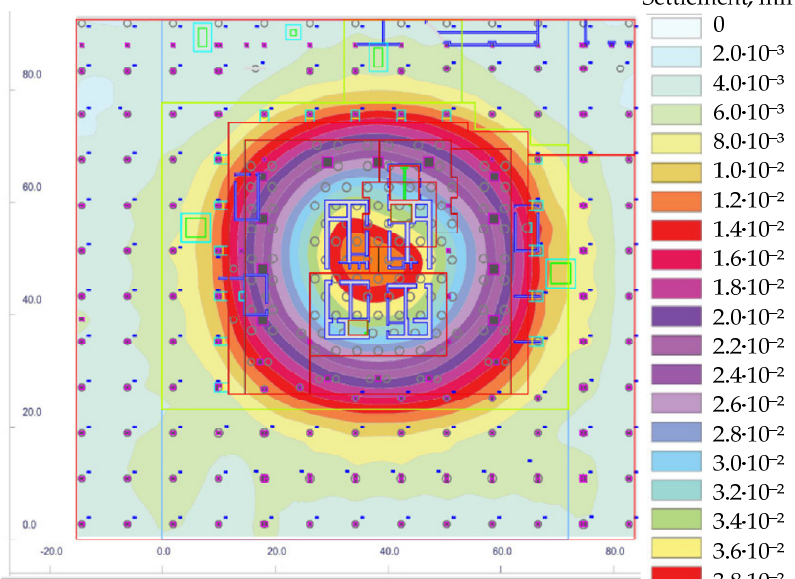
Figure 1. Vertical deformation plan of raft foundation according to the simulation of Buranbayeva et al. [1] using GARP software.